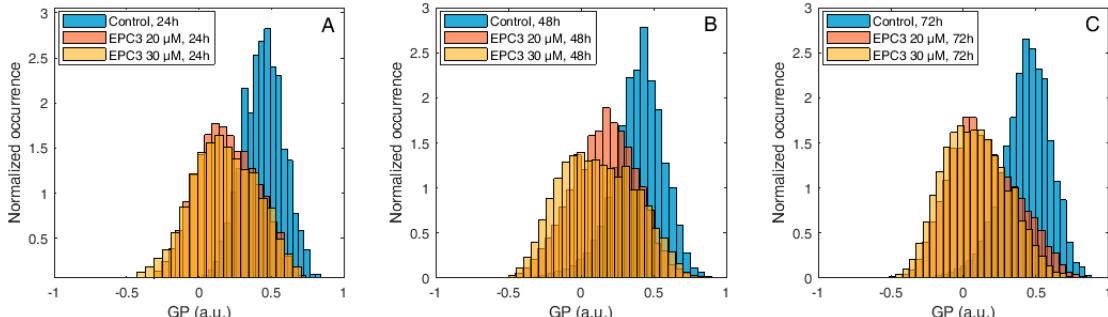
Figure 3. Di-4-ANEPPDQH generalized polarization (GP) values measured at the plasma membrane (PM) of MDA-MB-231 cells after EPC3 treatment. Normalized histograms of GP values measured in pixels belonging to the PM of MDA-MB-231 cells labeled with Di-4-ANEPPDQH. Cells were treated with 20 µM (orange bars) or 30 µM (yellow bars) EPC3. GP values measured in cells not treated with EPC3 are shown as blue bars. Fluorescence intensity values were acquired 24 h ( A ), 48 h ( B ), and 72 h ( C ) after the addition of EPC3. For each condition, GP values were pooled from ca. 50 ROIs selected at the PM of distinct cells, in two independent experiments. The total number of calculated GP values (and measured pixels) for each experimental condition was between ca. 10,000 and 40,000. Measurements were performed at RT. Representative images of treated cells and ROIs are shown in Figures S1 and S3.